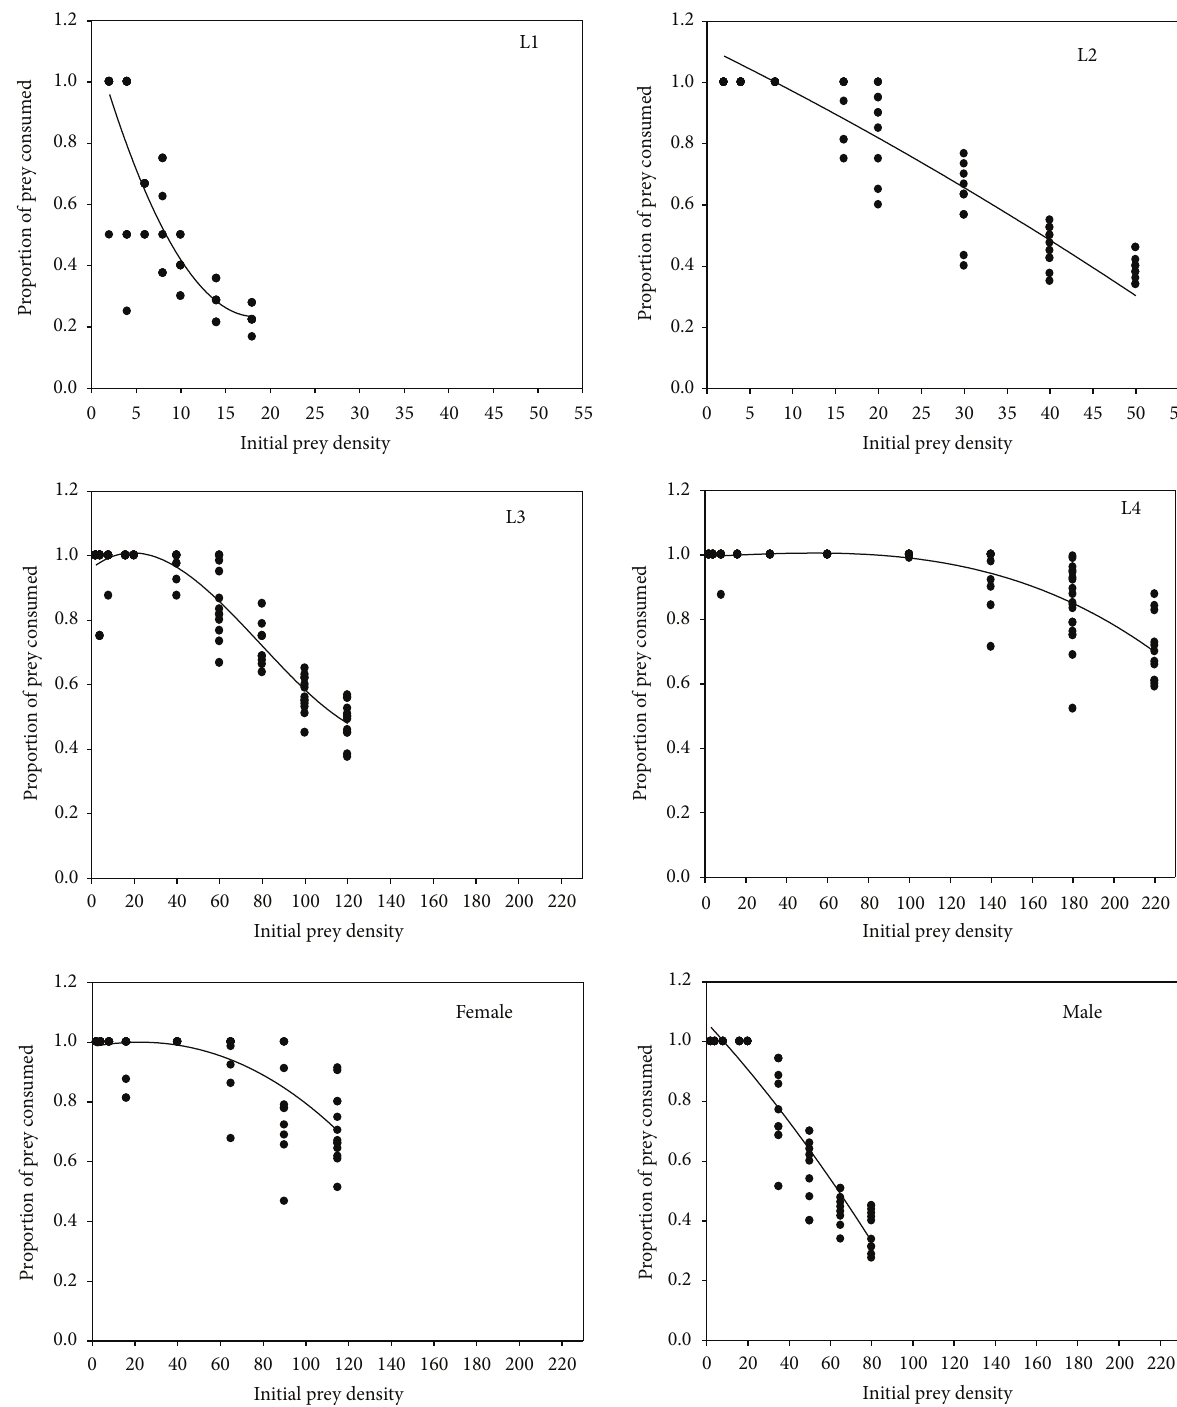
Figure 2: Proportion of N. viridis consumed by N. arcuatus in relation to prey density. L1: 1st instar larva, L2: 2nd instar larva, L3: 3rd instar larva, L4: 4th instar larva, M: male, and F: female. Symbols are observed data and lines were predicted by model.